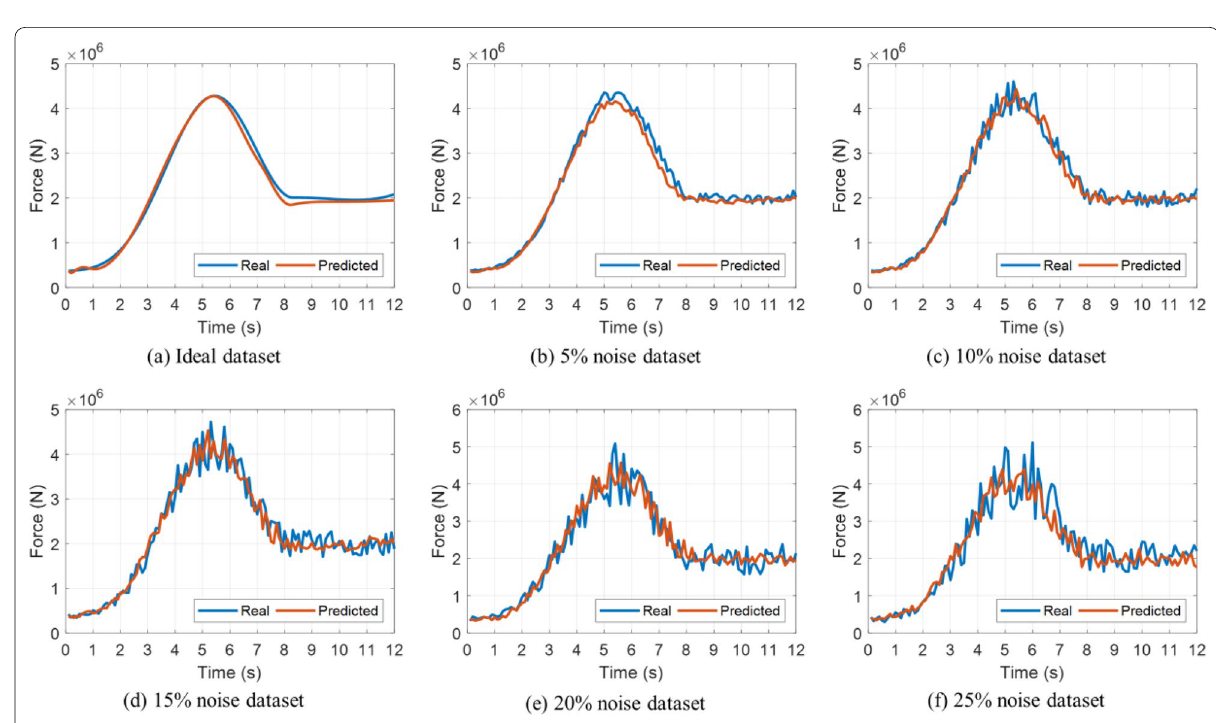
Figure 9 Prediction results of hoist force under different noise